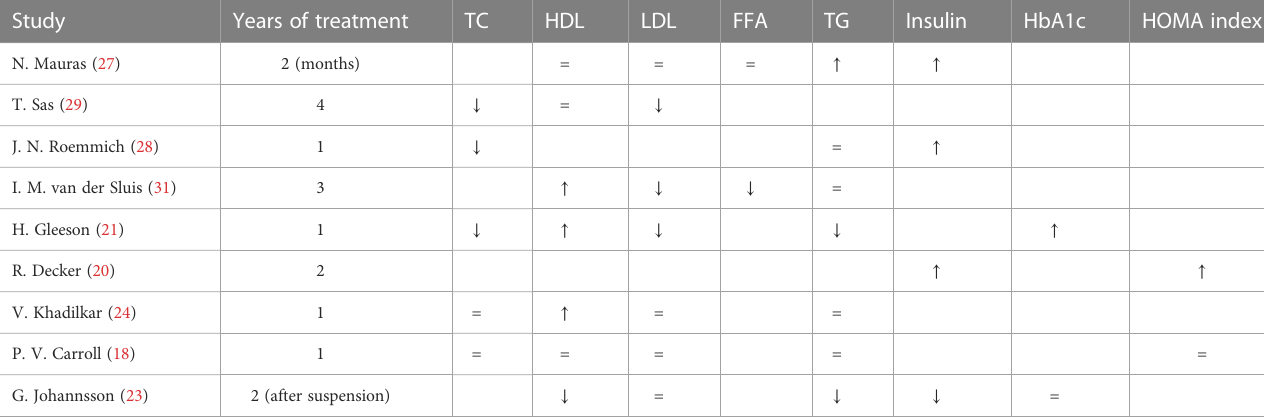
FFA, free fatty acids; GHD, growth hormone de fi ciency; HbA1c, serum glycated hemoglobin; HDL, high-density lipoprotein cholesterol; HOMA, homeostasis model assessment; LDL, low-density lipoprotein cholesterol; rhGH, recombinant human growth hormone; TC, total cholesterol; TG, triglycerides. ↓ , endpoint decreased; ↑ , endpoint increased; =, no change shown in endpoint.